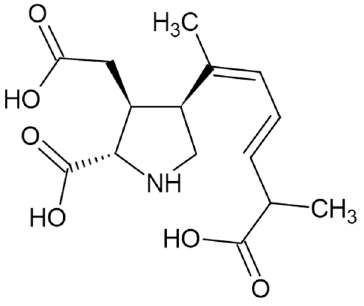
Figure 12. Chemical structure of domoic acid.